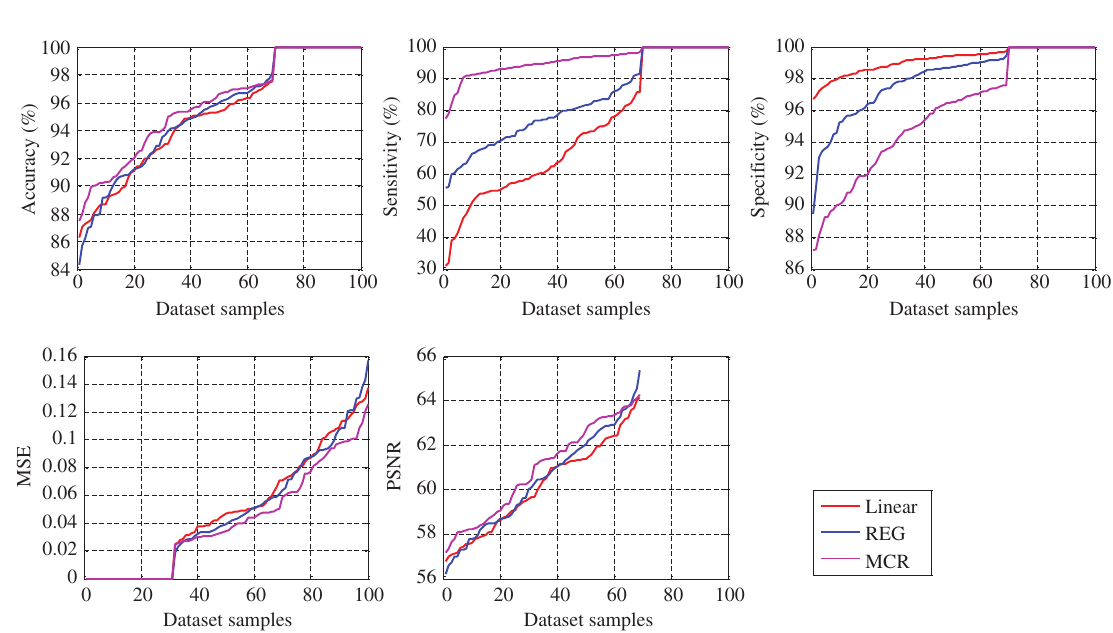
Figure 7: Graphs Showing Performance Analysis for Linear, Registration and MCR-based